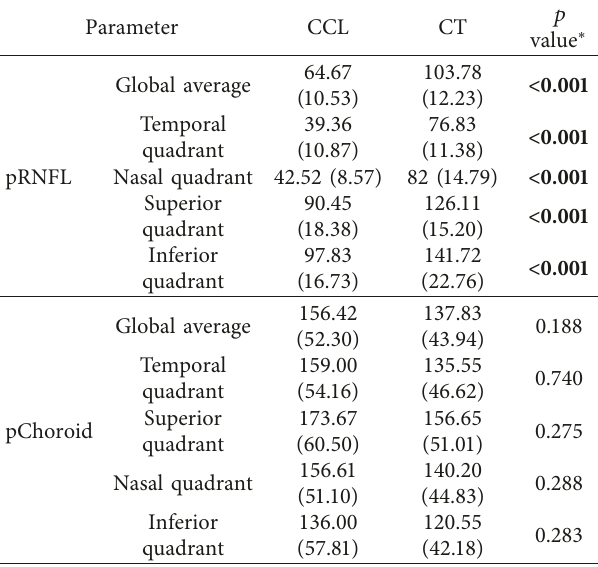
Figure 1: Choroidal and retinal nerve fiber layer (RNFL) evaluation of a right optic disc. (a) Optical coherence tomography (OCT) showing a B-scan in the peripapillary area with the RNFL and choroidal layer delimited in green and red, respectively. (b) Fundus photography of the right eye and the peripapillary area of OCT acquisition delimited by a white circle centered on the optic nerve head and divided into four sectors (temporal, superior, nasal, and inferior). Table 2: Mean values ( ± standard deviation) of peripapillary retinal nerve fiber layer and choroidal thickness measurements ( μ m) in eyes with temporal hemianopia from chiasmal compressive lesions (CCL) and healthy controls